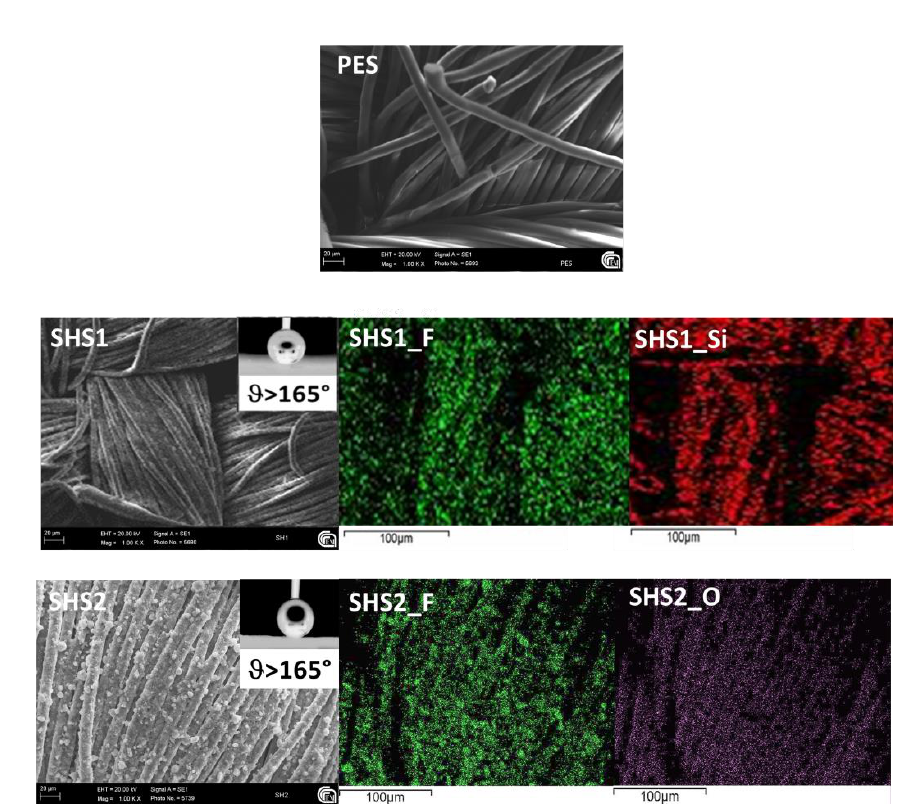
Figure 1. Surface morphology (1000×) of uncoated and coated PES and contact angle (degrees), and EDS maps for F (green), O (purple) and Si (red) of PES fabrics with 2 different superhydrophobic (SH) treatments.